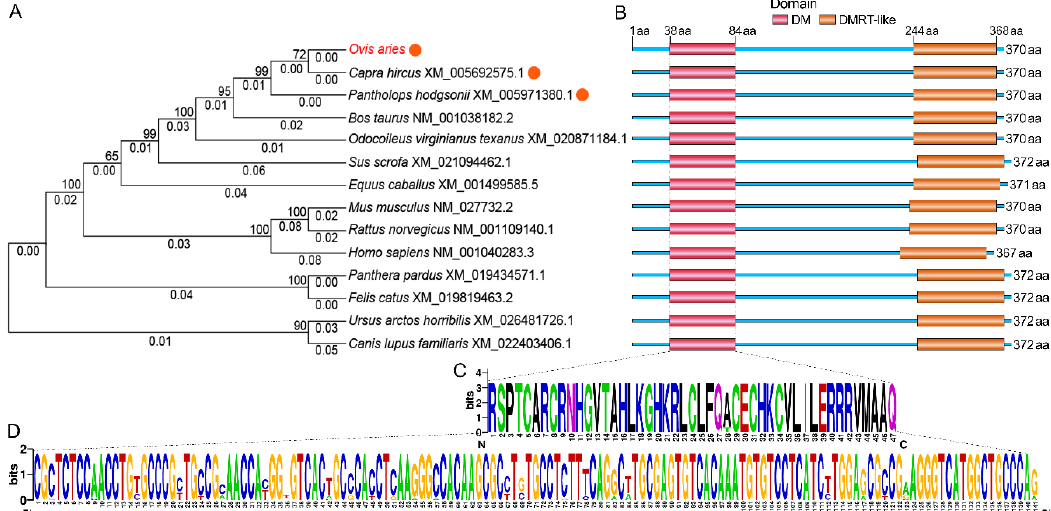
Figure 4. Phylogenetic tree and domain analysis of DMRTC2. ( A ) Neighbor-joining phylogenetic tree based on nucleotide sequences of DMRTC2 gene among different mammals. The bootstrap values (greater than 50) and branch lengths (less than 1) were showed above and below each branch, respectively. The closest homology with ovine DMRTC2 is indicated by orange circle. ( B ) DMRTC2 protein domain prediction among different mammals. Weblogo tool was used to show the amino acid ( C ) and nucleotide ( D ) composition of the DM domain.